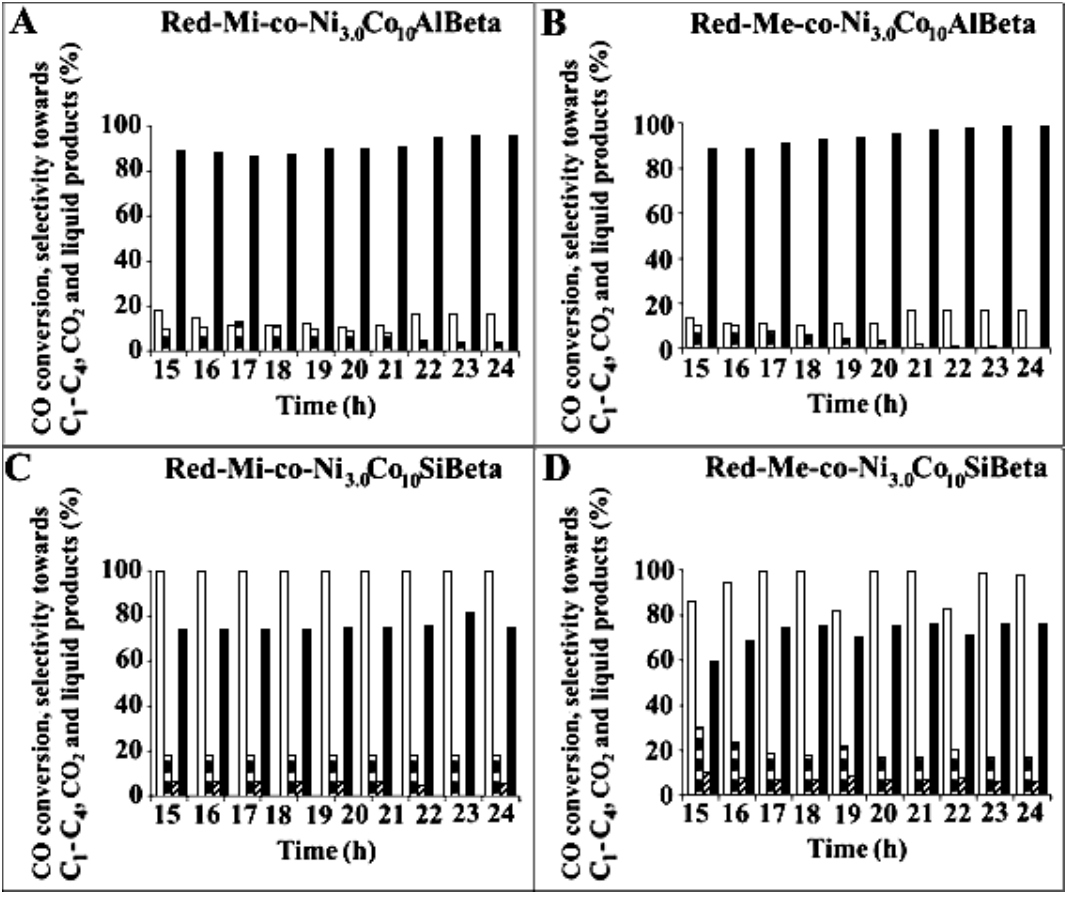
Figure 9. Conversion of CO ( ) and selectivity to C 1 -C 4 ( ), CO 2 ( ) and liquid products ( ) after Fischer-Tropsch synthesis (T = 260 °C, p = 30 atm, t = 24 h) over ( A ) Red-Mi-co-Ni 3.0 Co 10 AlBeta, ( B ) Red-Me-co-Ni 3.0 Co 10 AlBeta, ( C ) Red-Mi-co-Ni 3.0 Co 10 SiBeta, ( D ) Red-Me-co-Ni 3.0 Co 10 SiBeta.